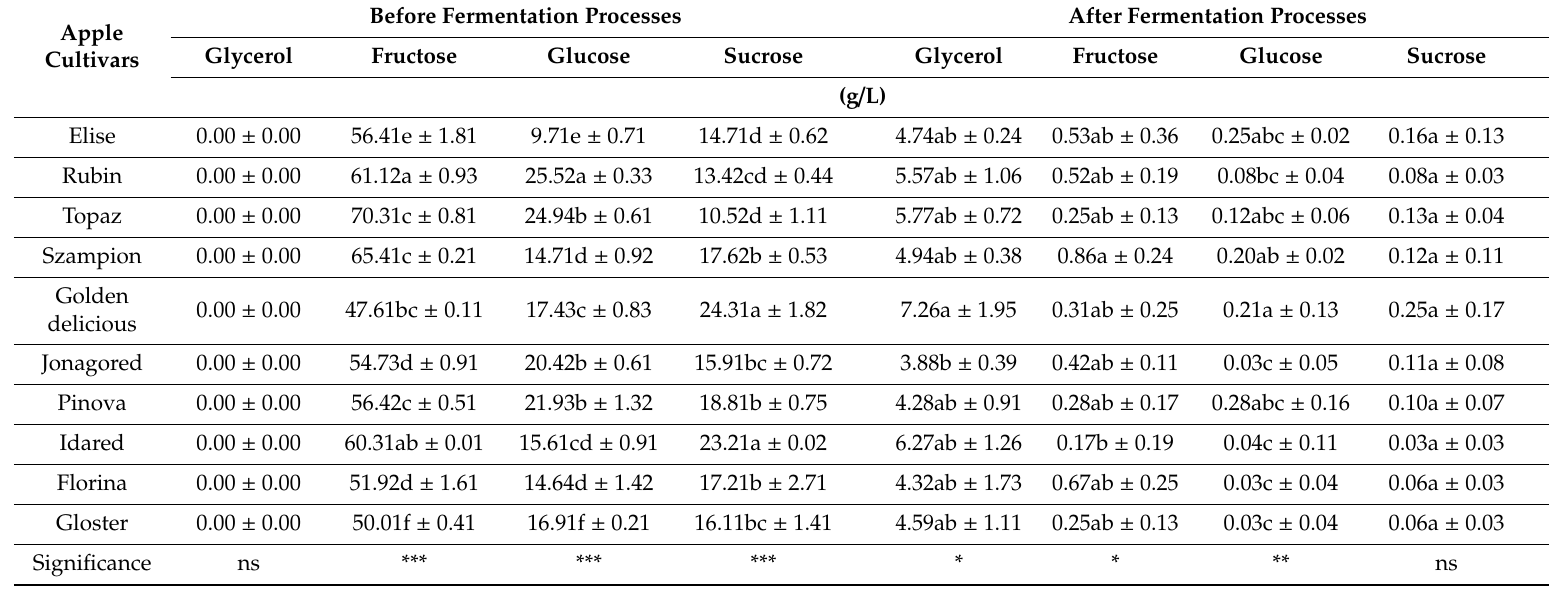
Table 1. Sugar composition of fresh and fermented musts obtained from various apple